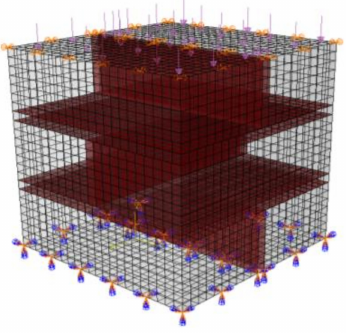
Figure 12. Masonry cubic model.